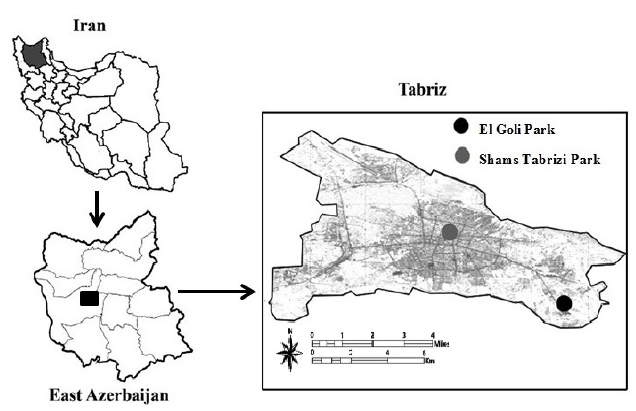
Figure 1: Map of the Study Area However, based on “Tabriz view in 2018”, the green space per capita should be increased to 25 m 2 per capita. Even though the commitment is applicable, Tabriz like other city in Iran is facing a lack of rain and snow so development of green areas need very high investment.